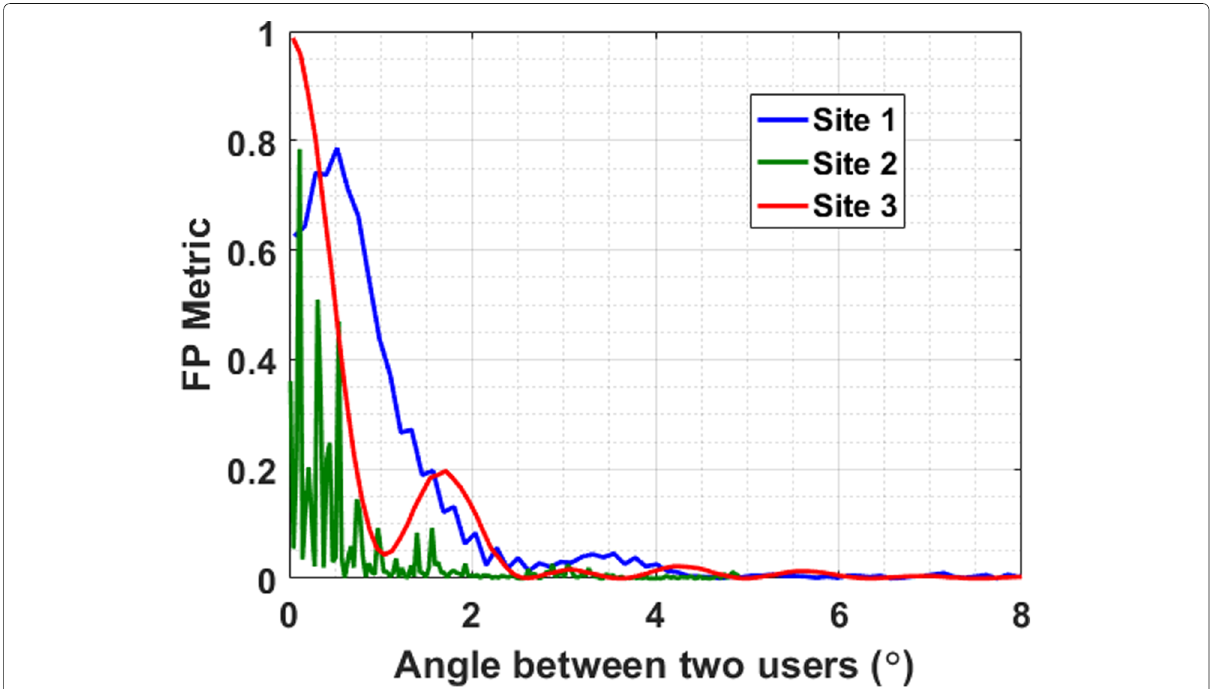
Fig. 9 Minimum angle required between the two users to obtain FP-like